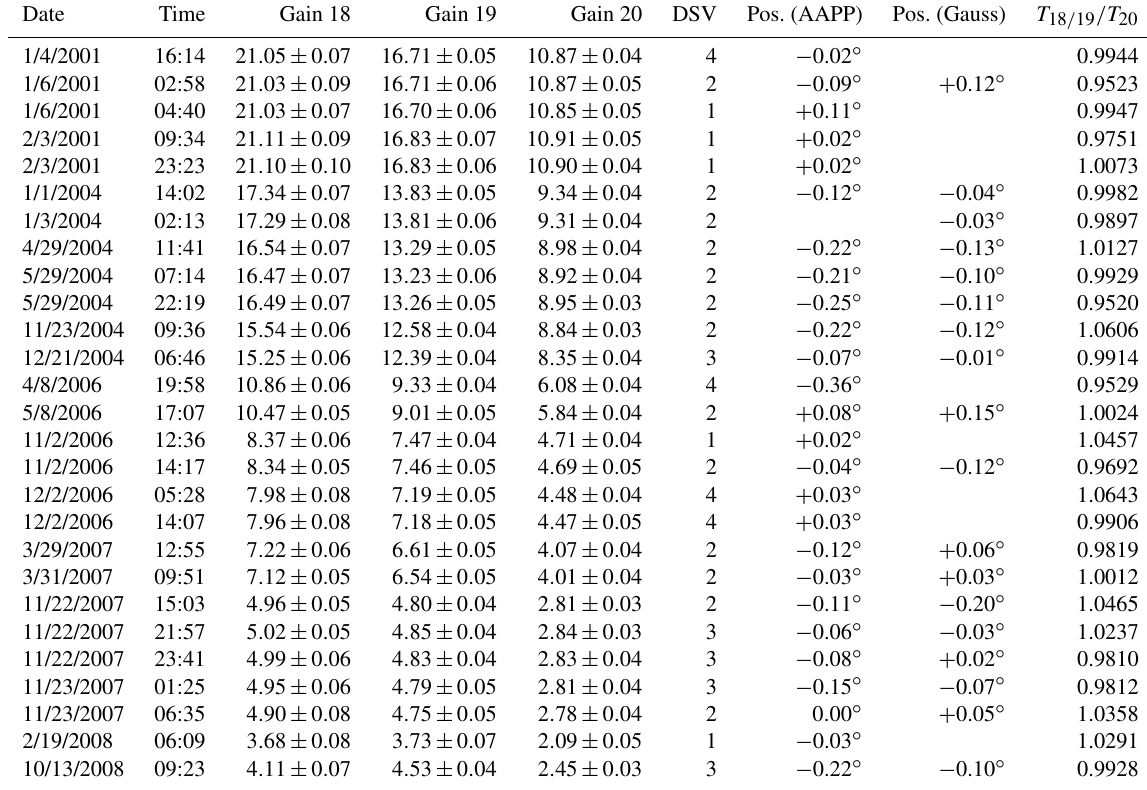
Table 1. Results from Gaussian fits to the light curves of Moon intrusions in DSVs of AMSU-B on NOAA-16. Columns 1 and 2: date and time of occurrence of smallest lunar angle. Columns 3–5: gain in countsK − 1 . Column 6: number of DSV pixel closest to the Moon. Column 7: minimum lunar angle as calculated with AAPP. Column 8: minimum lunar angle as calculated from maximum signal in each DSV. Column 9: ratio of brightness temperatures in channels 18, 19 (averaged), and channel